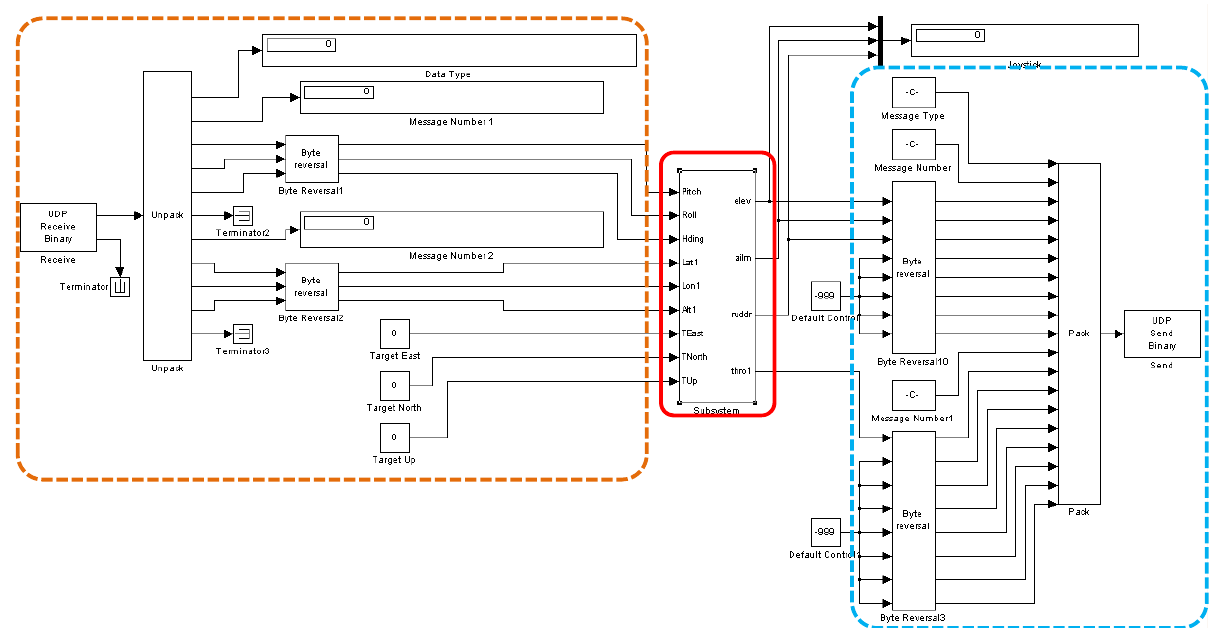
Figure 19. The architecture of the FCS in